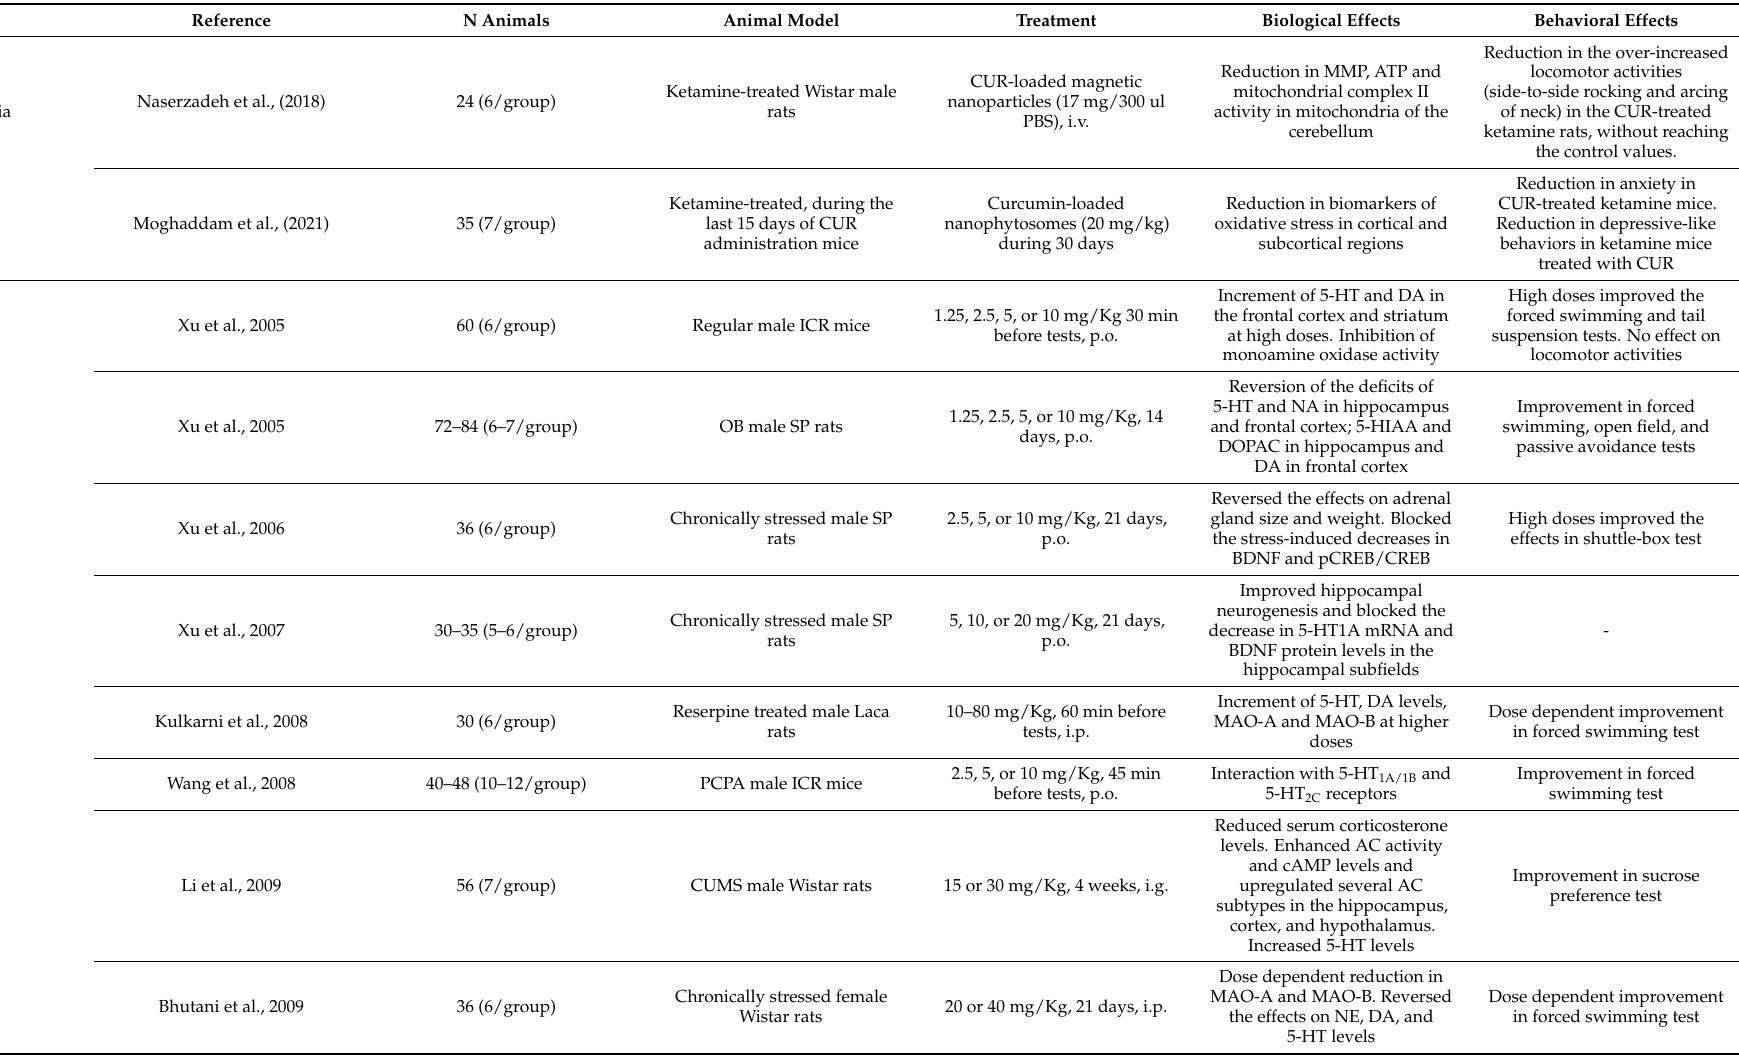
Table 2. Preclinical studies in neuropsychiatric